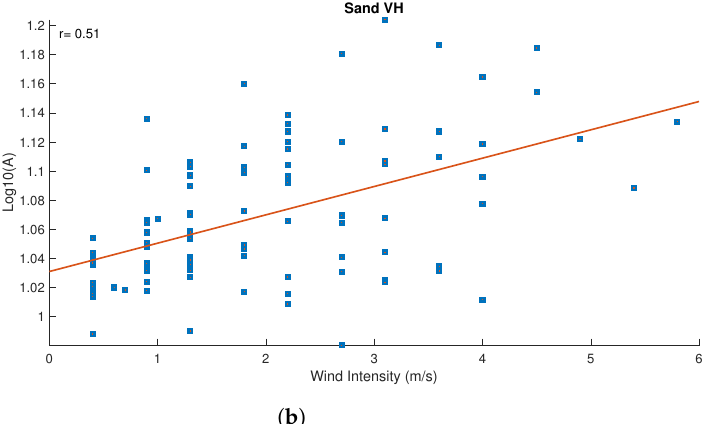
Figure 10. Correlation factor between wind intensity and amplitude on the sand mask for VV ( a ) and VH ( b ) polarization.